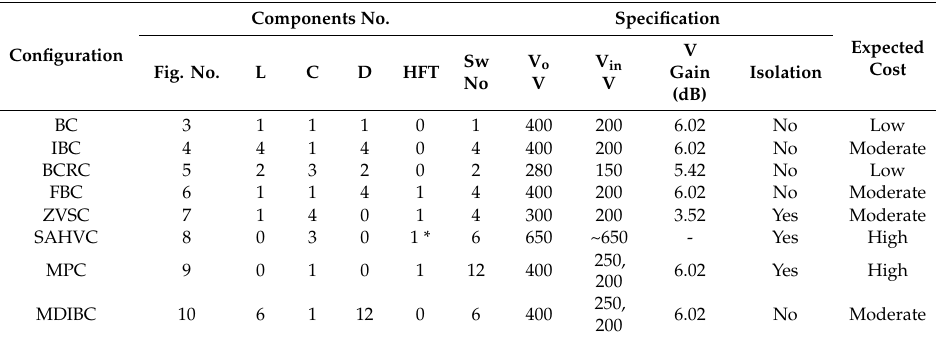
Fig. No. = figure number, L = inductor, C = capacitor, D = diode, HFT = High frequency transformer, * = centre tap transformer, Sw No = number of switches (MOSFETs / IGBTs), Vo = output voltage, Vin = input voltage, Vol. = volume, Wgt. = weight, VGain = Voltage gain in